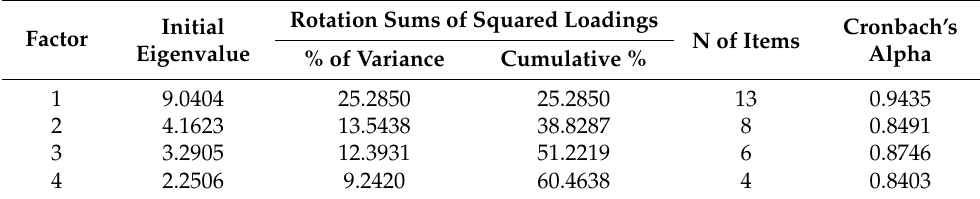
Table 2. The four-factor